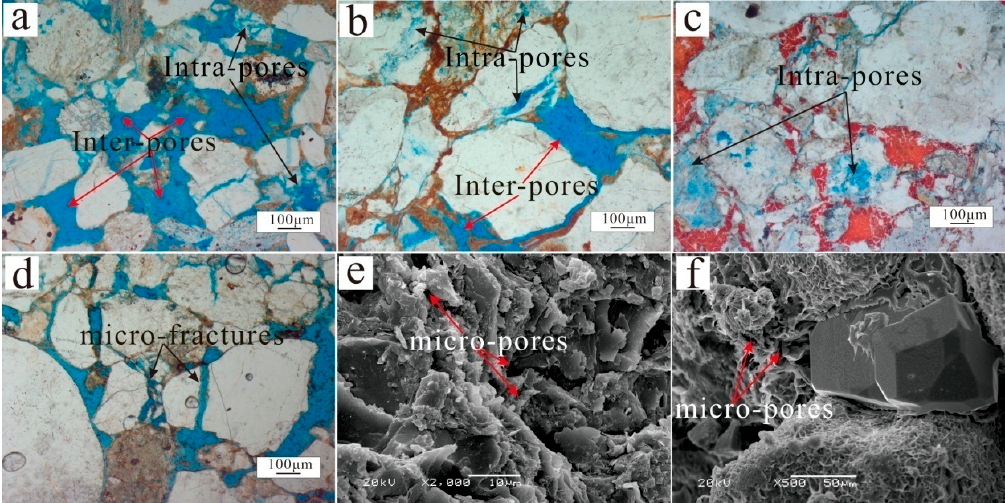
Figure 6. Pore types ( a – f ) in Lulehe sandstones reservoir. Inter-pores: intergranular pores; Intra-pore: intragranular pores.